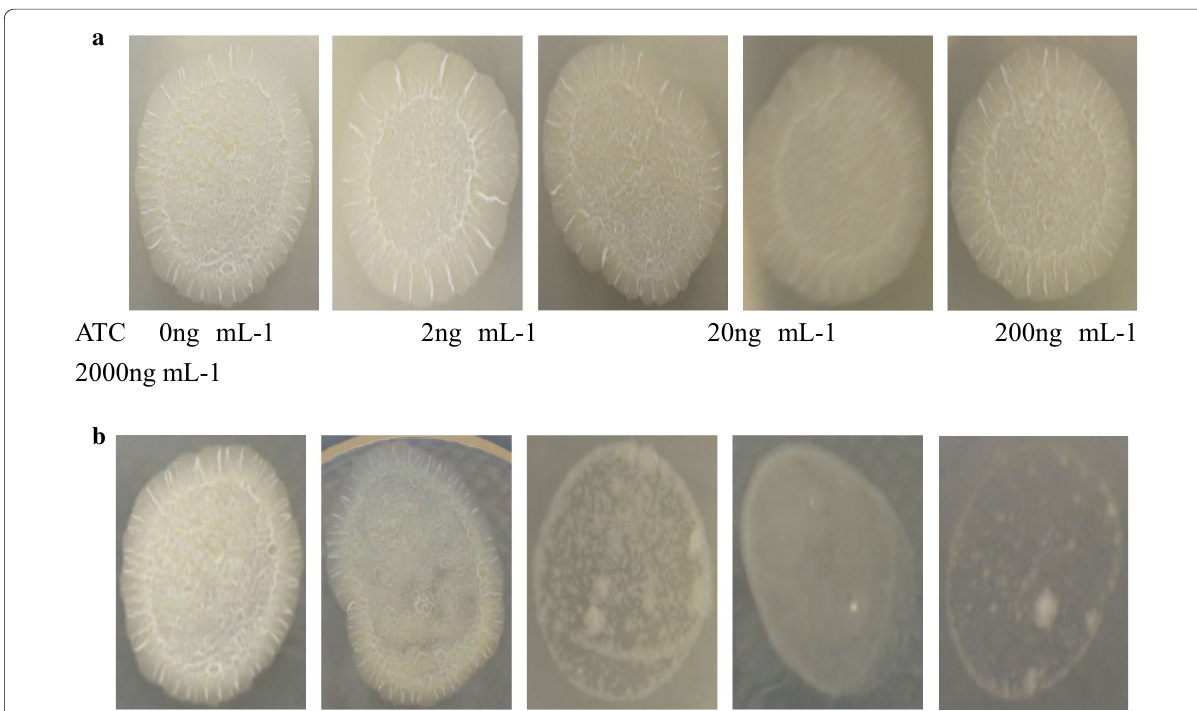
Fig. 2 Bacterial colony formation of the wild-type strain ( a ) and mutant strain ( b ) at different concentration of anhydrotetracycline